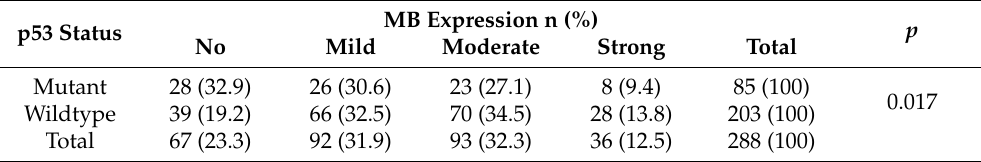
Table 1. Correlation of myoglobin (MB) expression to p53